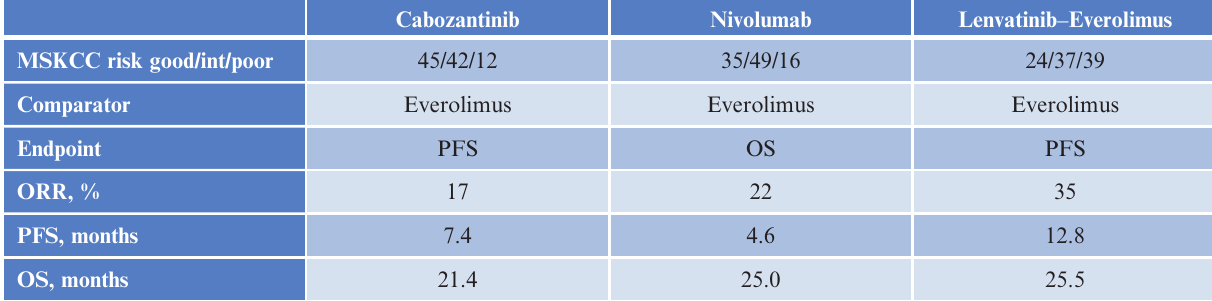
Table 2. Second-line trials (METEOR/CheckMate 025/Lenvatinib –